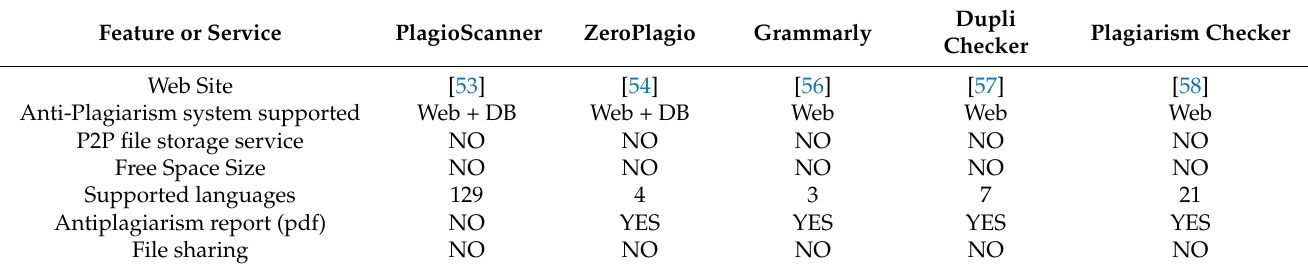
Table 2. Anti-Plagiarism Apps Features and